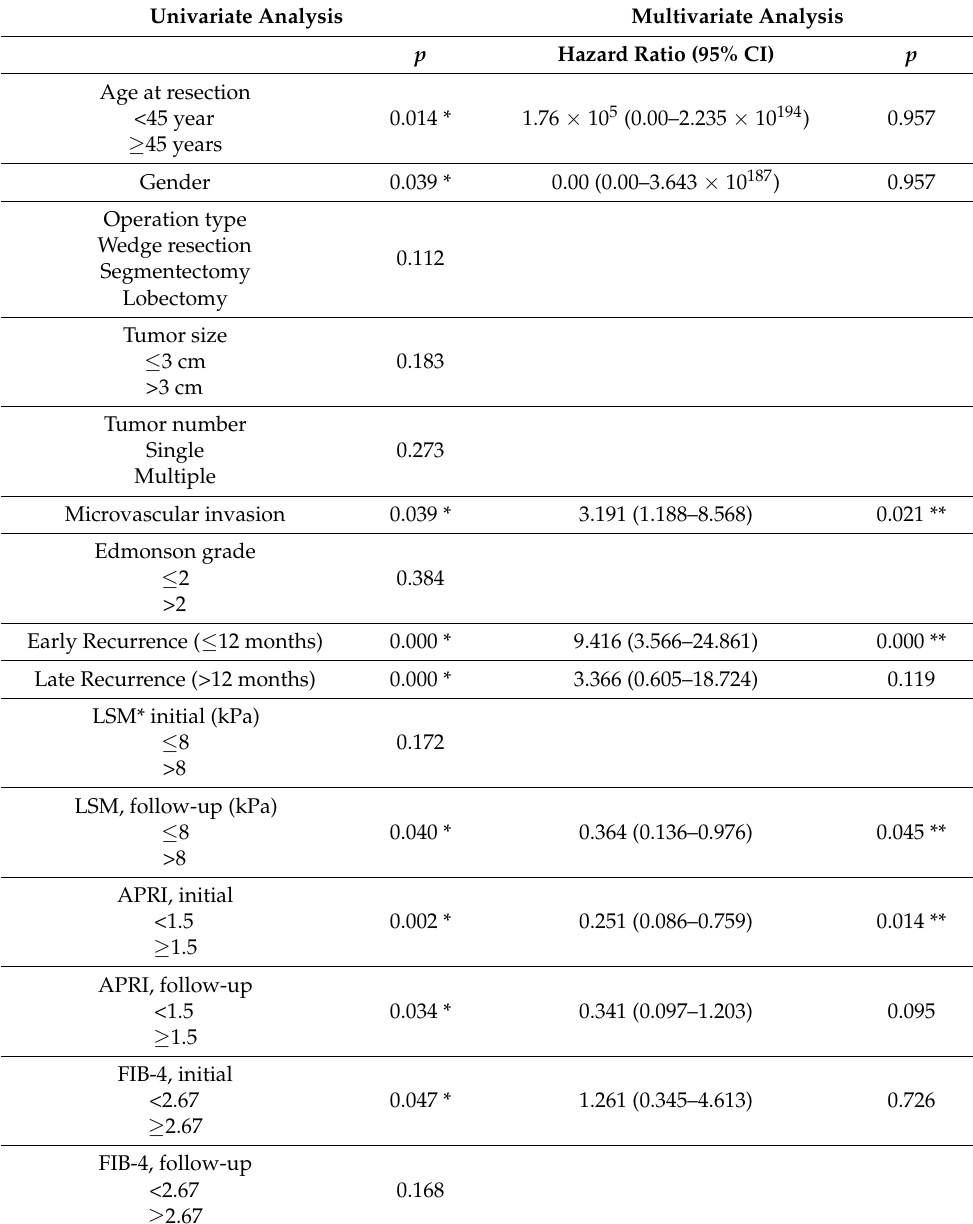
Table 6. Independent predictions of mortality after curative HCC resection in patients with pathologically confirmed liver cirrhosis under antiviral